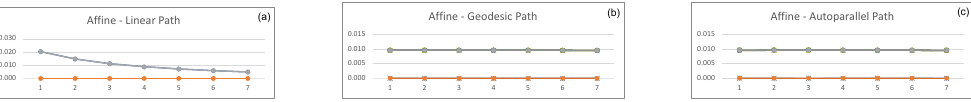
Figure 5. Trend of the energies for different interpolations: ( a ) Left: linear interpolation ( b ) Center: geodesics interpolation. ( c ) Right: autoparallel interpolation. Blue refers to d u , red to d b , grey to d tot .